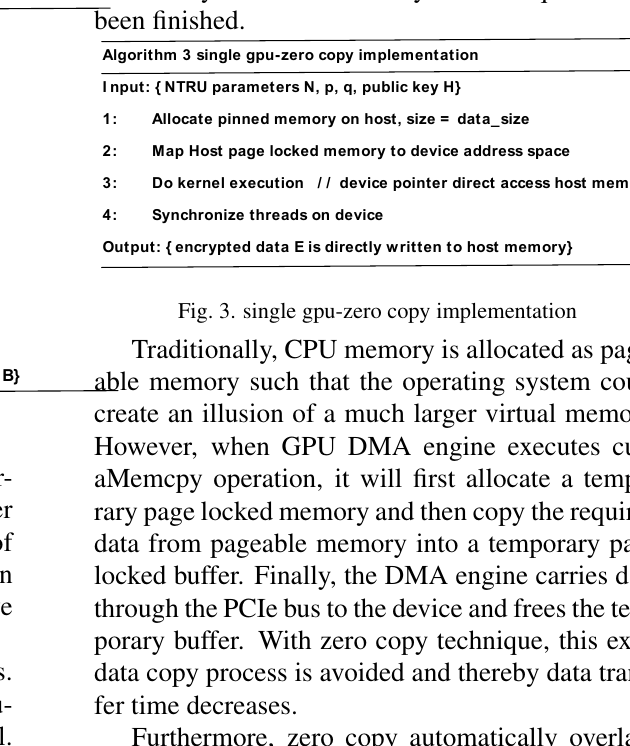
Algorithm 2 convolution production